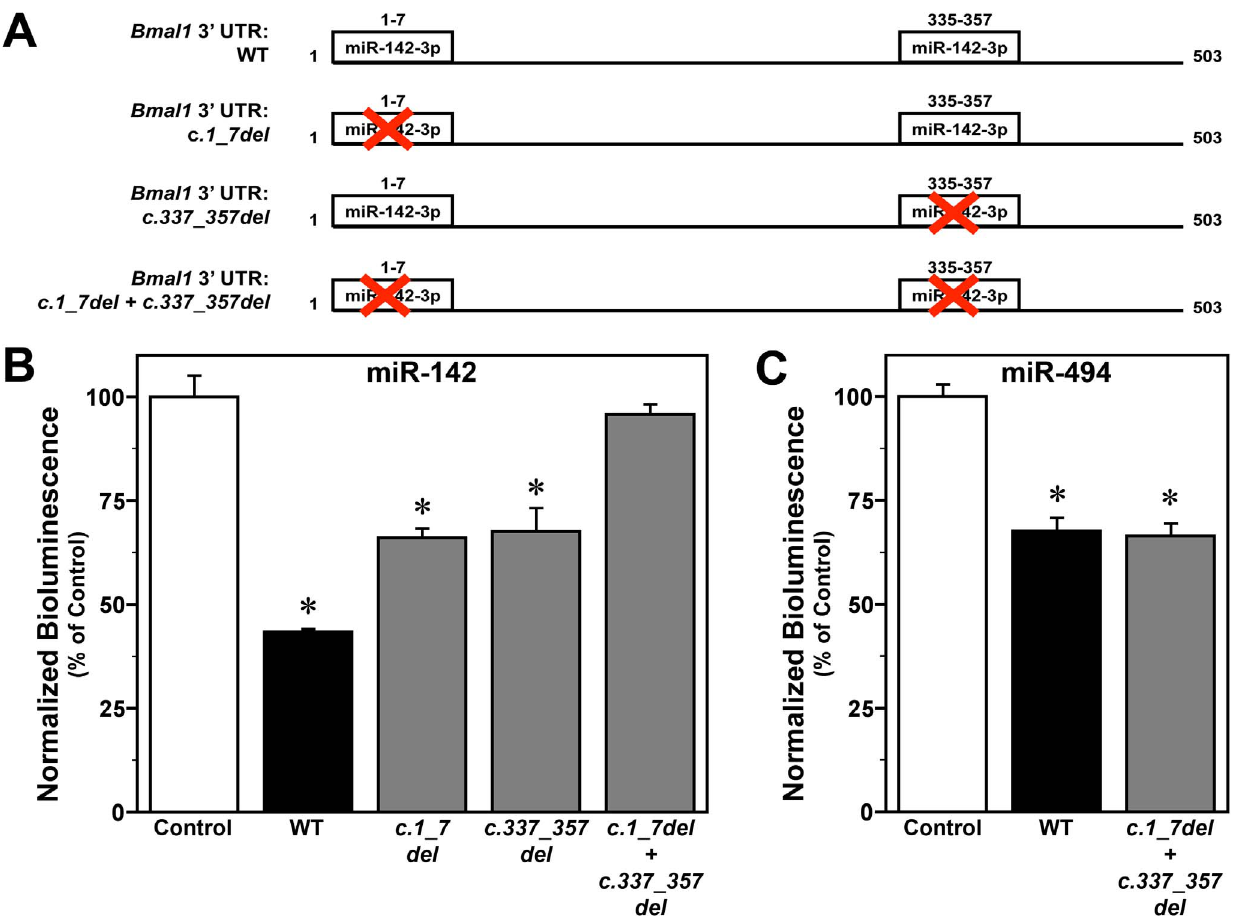
Figure 3. Effects of binding site mutagenesis on miR-142-3p-induced repression of Bmal1 3 9 UTR activity. (A) Diagrammatic representation of WT and mutagenized Bmal1 3 9 UTR constructs with independent site-directed deletions of predicted miR-142-3p binding sites. (B) Normalized bioluminescence from HEK293 cells co-transfected with pEZX-MR04 miR-142 expression vector and with either the target control, full- length Bmal1 (WT), Bmal1 c.1_7del, Bmal1 c.335_357del or Bmal1 c.1_7del + c.335_357del miRNA 3 9 UTR target clones. (C) Normalized bioluminescence from HEK293 cells co-transfected with pEZX-MR04 miR-494 expression vector with either the target control, full-length Bmal1 (WT), Bmal1 c.1_7del, Bmal1 c.335_357del or Bmal1 c.1_7del + c.335_357del miRNA 3 9 UTR target clones. Bars represent mean ( 6 SEM) determinations of